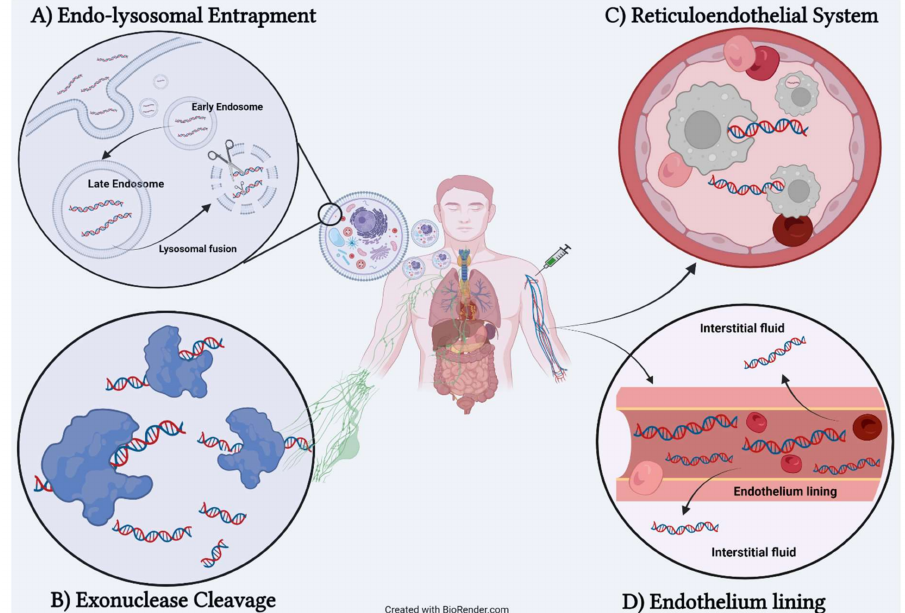
Figure 3. Four biological barriers preventing activity of therapeutic oligonucleotide. ( A ) Endo- lysosomal entrapment. ON required escape from late endosome before subjected to lysosomal degradation. ( B ) Exonuclease cleavage. Initiate hydrolysis of phosphodiester backbone, which deteriorate ON. ( C ) Reticuloendothelial system. Digestion of ON by macrophage can terminate its activity. ( D ) Endothelium lining. Blockage of transverse ON from vascular lumen to interstitial